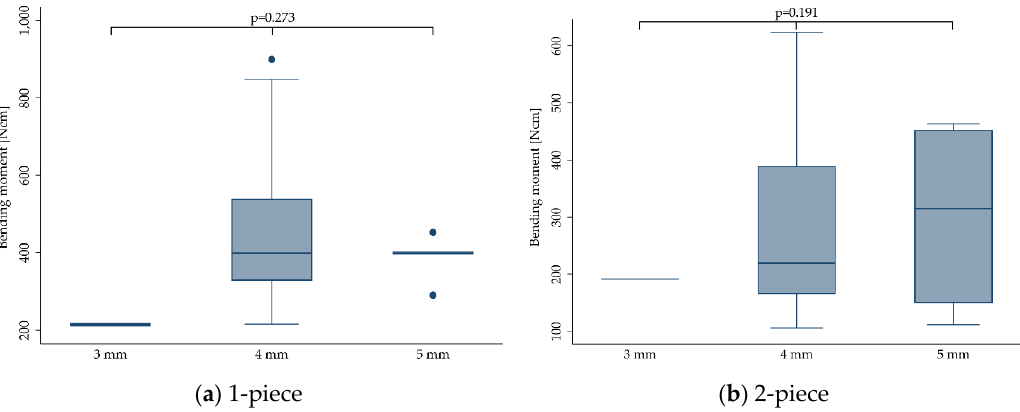
Figure 5. Boxplots showing the bending moment at the time point of fracture depending on the implant diameter for 1- ( a ) and 2-piece ( b ) zirconia implants. Whiskers are used to represent all samples lying within 1.5 times the interquartile range. Dots represent outliers. Detailed data can be found in Tables 3 and 4.